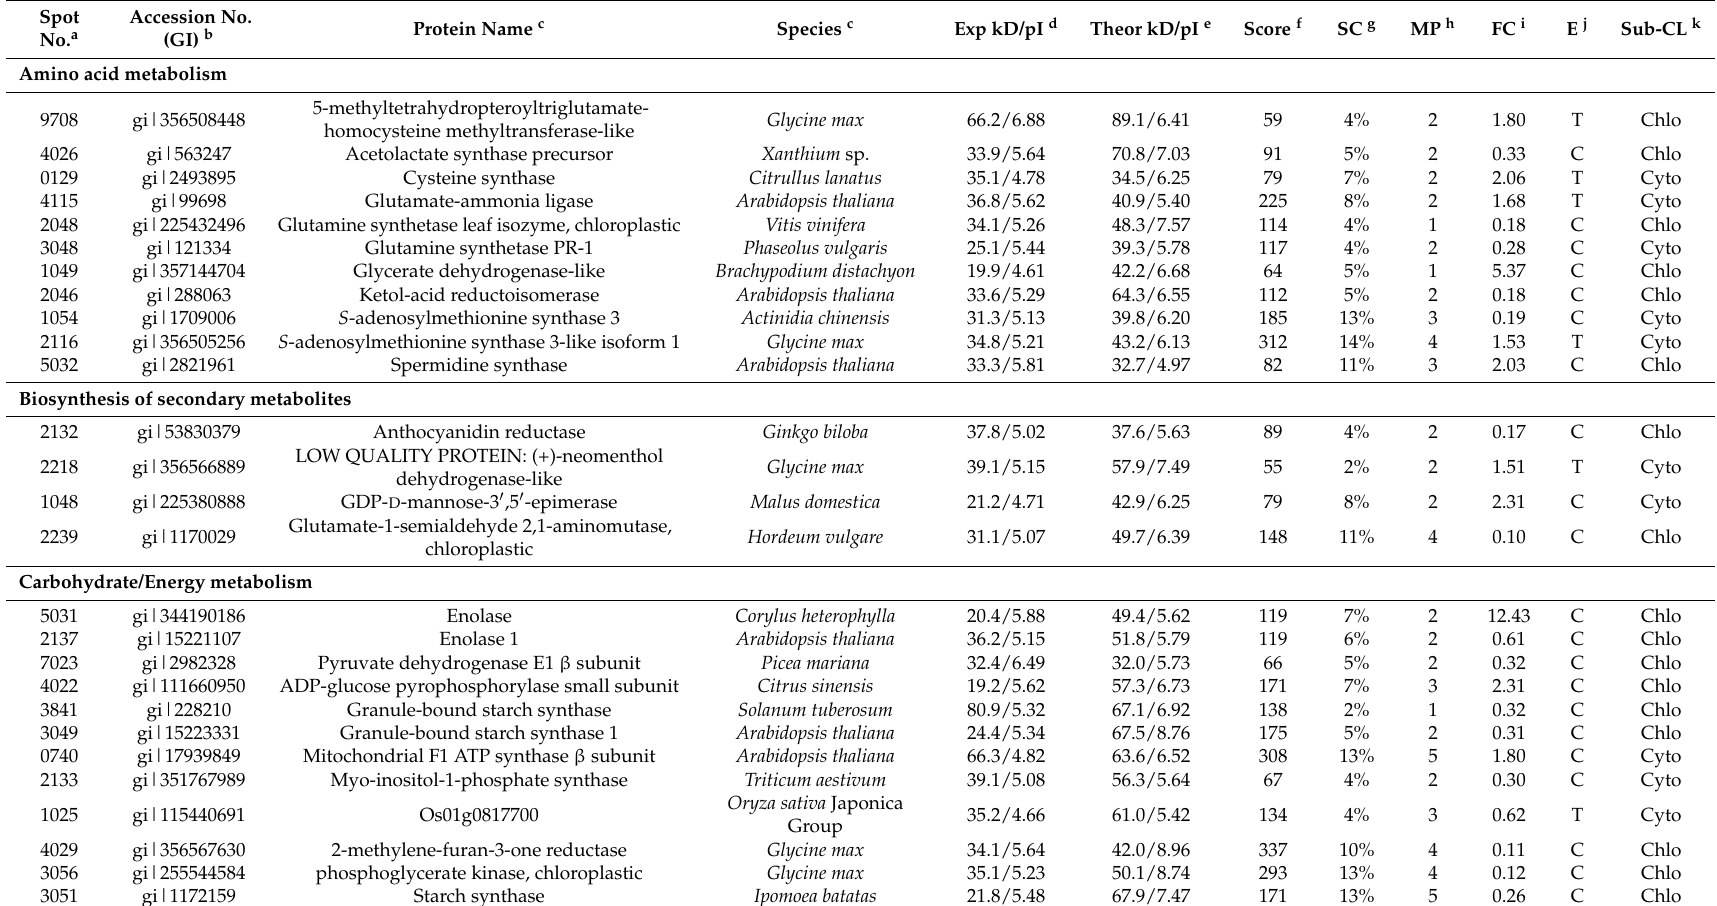
Table 1. Identification and database search of differentially accumulated proteins in G. biloba